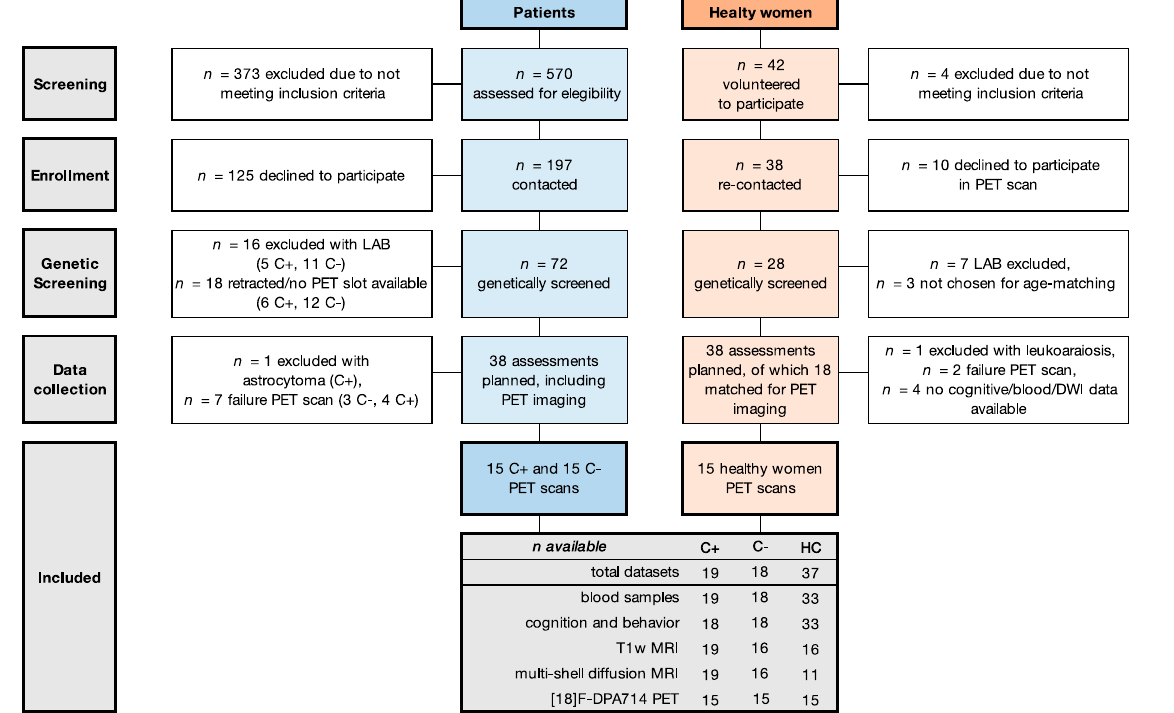
Figure 1. Flow diagram of included participants. Abbreviations: C- = chemotherapy-naïve breast cancer patients, C+ = breast cancer patients treated with chemotherapy, DWI = diffusion weighted imaging, HC = healthy controls, LAB = low affinity binder.